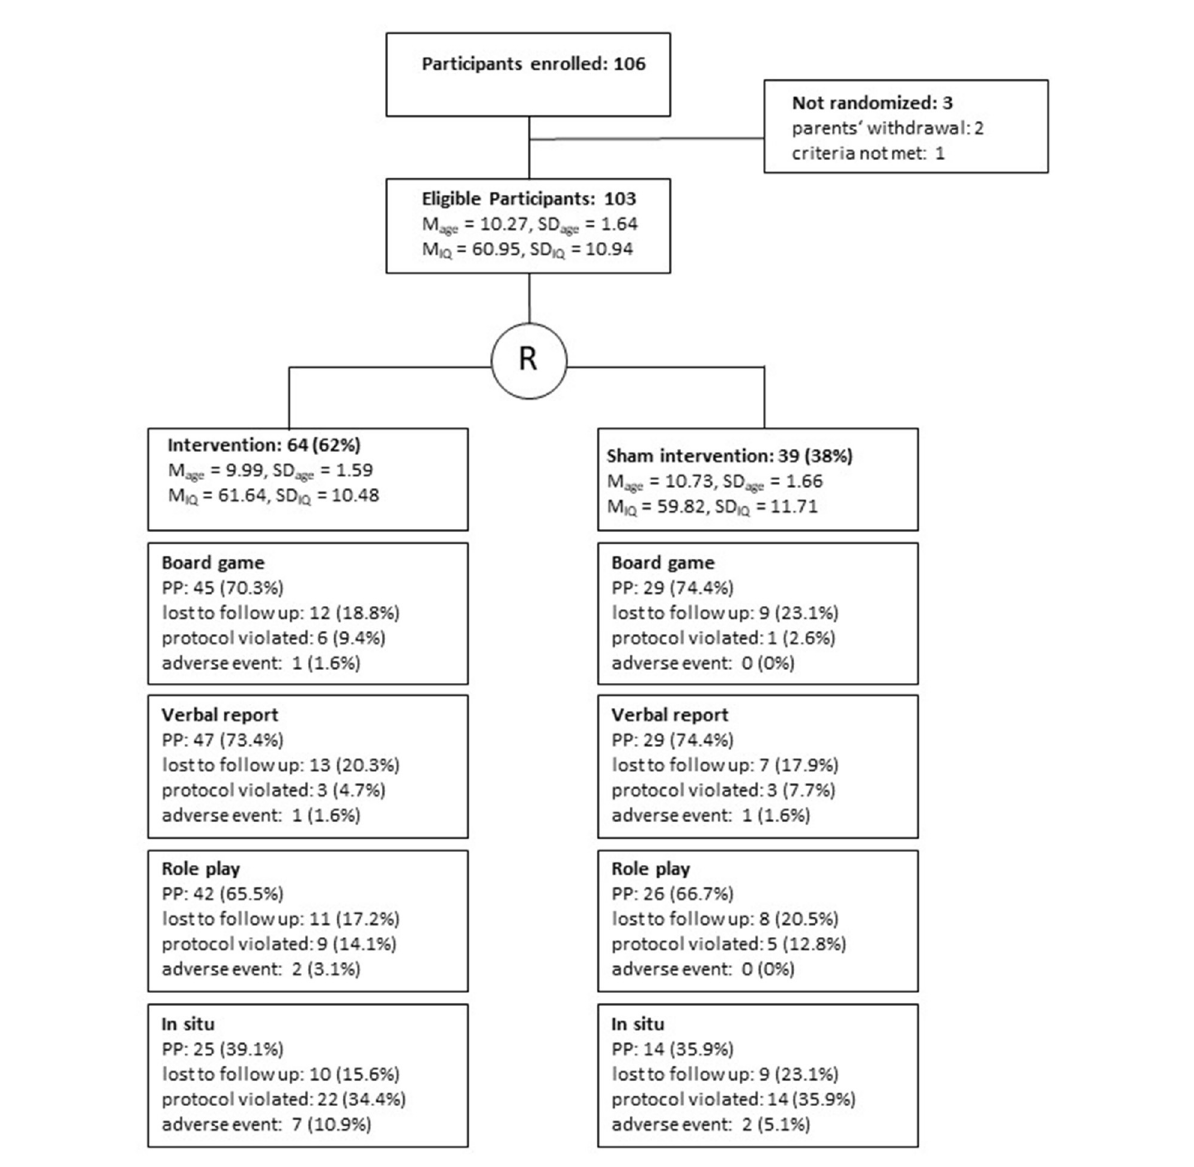
FIGURE2 Study flow for the evaluation of Emma-Untouchable, with drop-outs for different outcomes, reported at any time during the investigation, M, Mean; SD, Standard deviation; IQ, Intelligence Quotient; PP, Per protocol sample t 1 – t 3